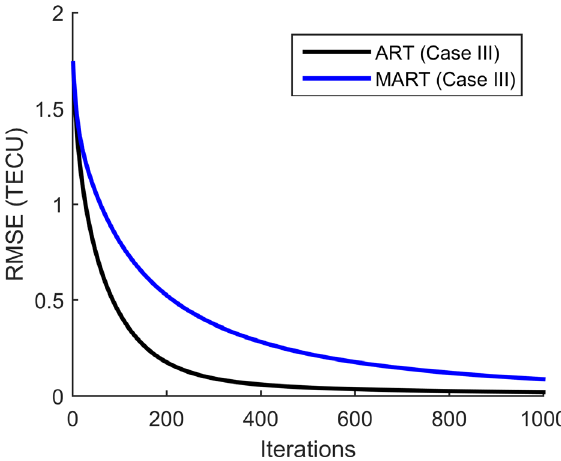
Figure 8 - The RMSE of TEC estimation by ART and MART in each iteration of Case III (height variation), which is the case with maximum RMSE.